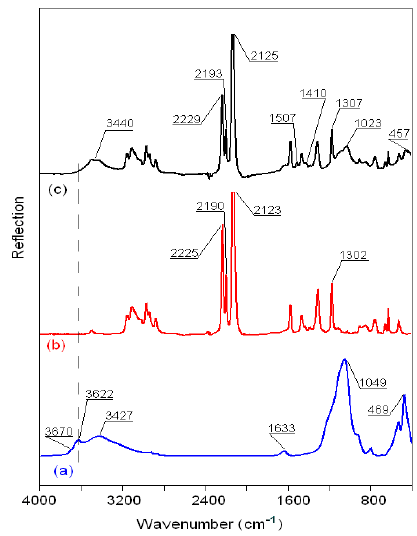
Figure 10. FTIR spectra of ( a ) MMT K10, ( b ) BMImDCA, and ( c ) MMT K10 / MImDCA. Table 4. Some important peaks in the FTIR spectra of pure ionic liquids BMImNTf 2 , BMImOTf, and BMImDCA, as well as pure MMT K10 clay, and their